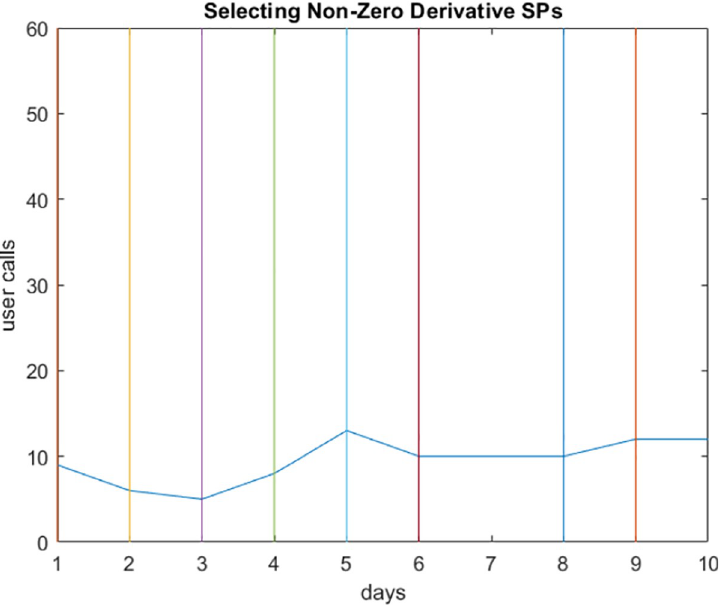
Fig 9. Selecting an SP to represent non-zero derivative periods. The SP for timestamp 7 was ( dx i =